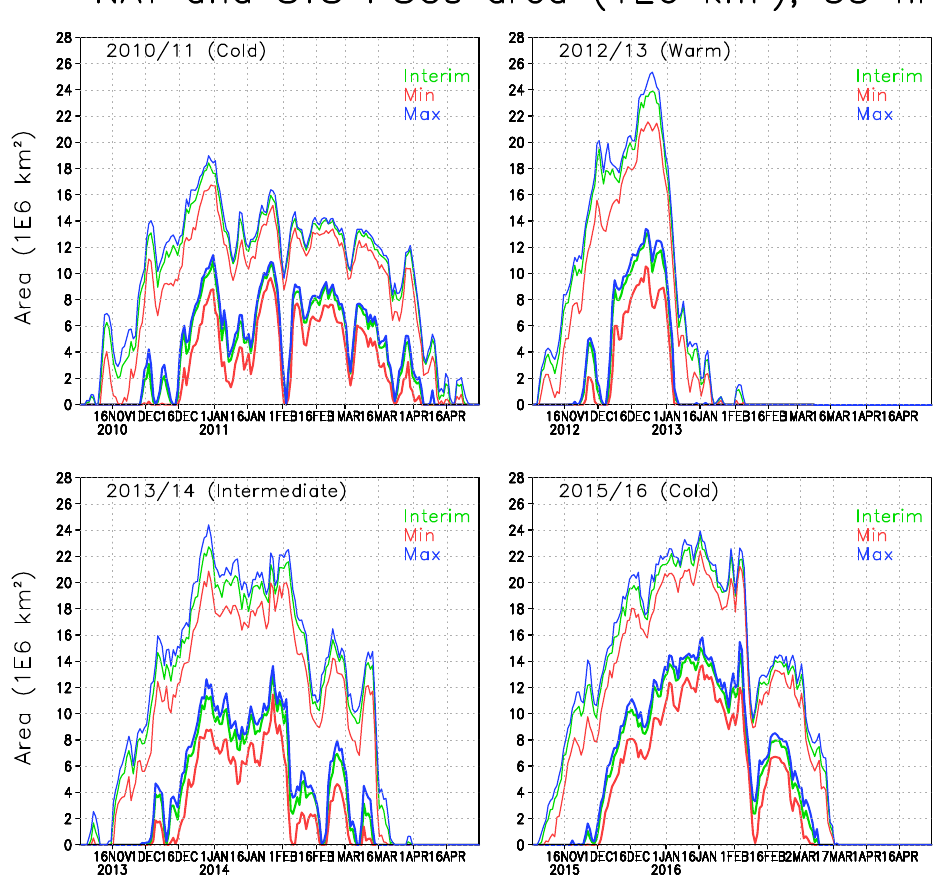
Figure 5. The area of NAT (thick lines) and STS PSCs (thin lines) (10 6 km 2 ) within the Arctic polar vortex in the simulations at 55hPa. The green line denotes the Interim simulation, blue denotes the Max simulation and red denotes the Min simulation.